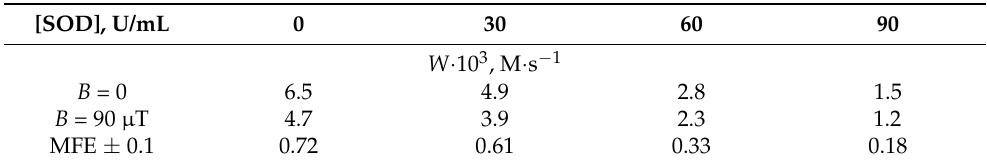
Table 4. Dependence of adrenaline consumption rate ( W ) and magnetic field effect (MFE) values on SOD activity in the absence of a magnetic field and in its presence. Carbonate buffer, pH = 10.60, [Adr] 0 = 68 µ M, air atmosphere, 310 K. [SOD],